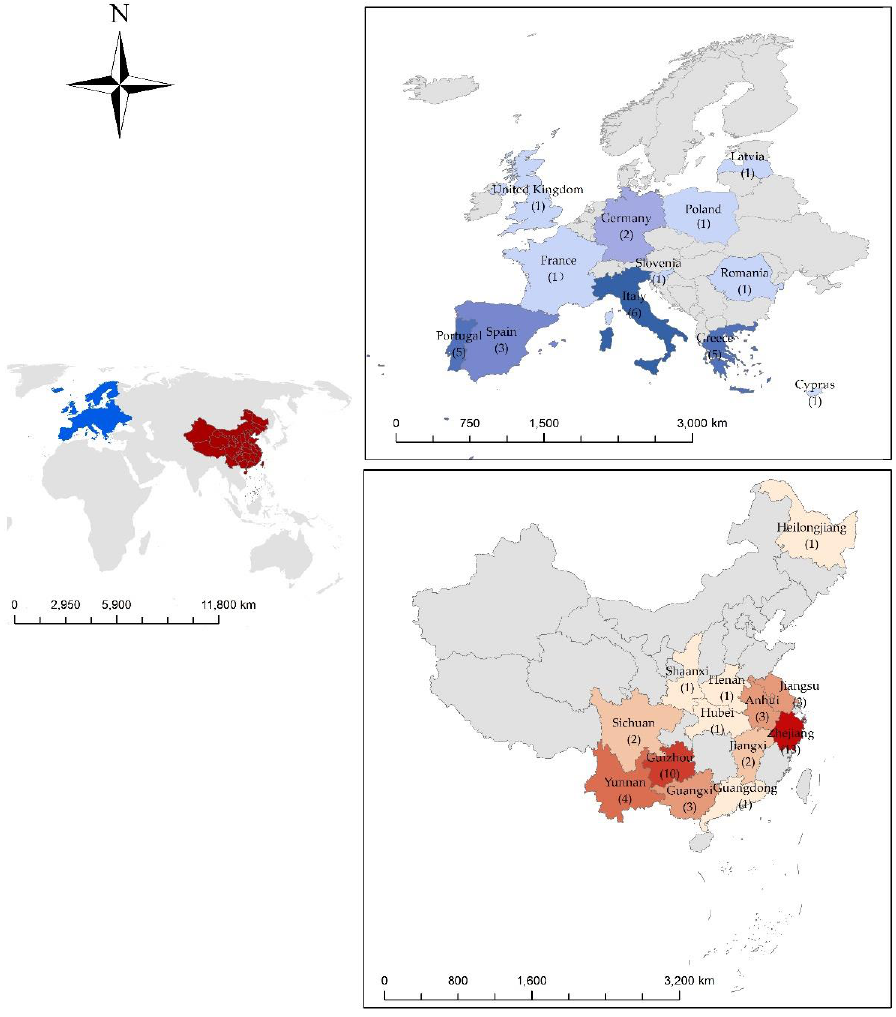
Figure 2. Geographic distribution of collected case studies in European and Chinese context. Authors’ elaboration based on map provided by Esri [ 42]. In European context, the case study villages were from Italy (21%), Portugal (17.8%), Greece (17.8%), Spain (10.7%), Germany (7.1%), Cyprus (3.5%), the UK (3.5%), Slovenia (3.5%), Latvia (3.5%), France (3.5%), Romania (3.5%), and Poland (3.5%) (Figure 2). It can be seen that in Southern Europe is the main area where the case study villages are distrib-